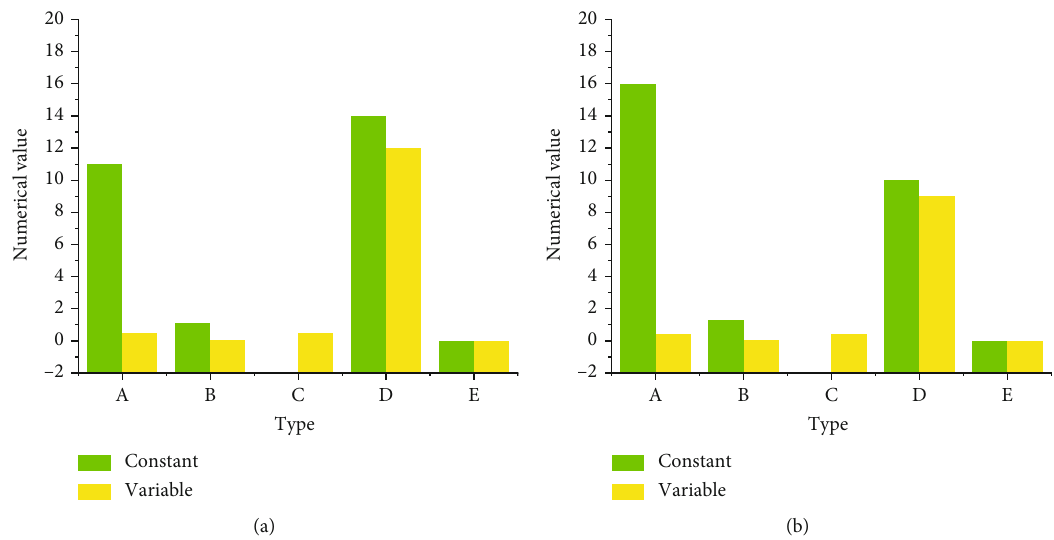
Figure 11: Regression analysis of leader narcissistic organizational identi fi cation on employees ’ mental health ((a) employees ’ mental health in pro fi t-making enterprises and (b) employees ’ mental health in employee-bene fi ting enterprises. A: B value in nonstandardized coe ffi cient; B: standard error in nonstandardized coe ffi cients; C: standardization coe ffi cient; D: t value; and E: Sig.).